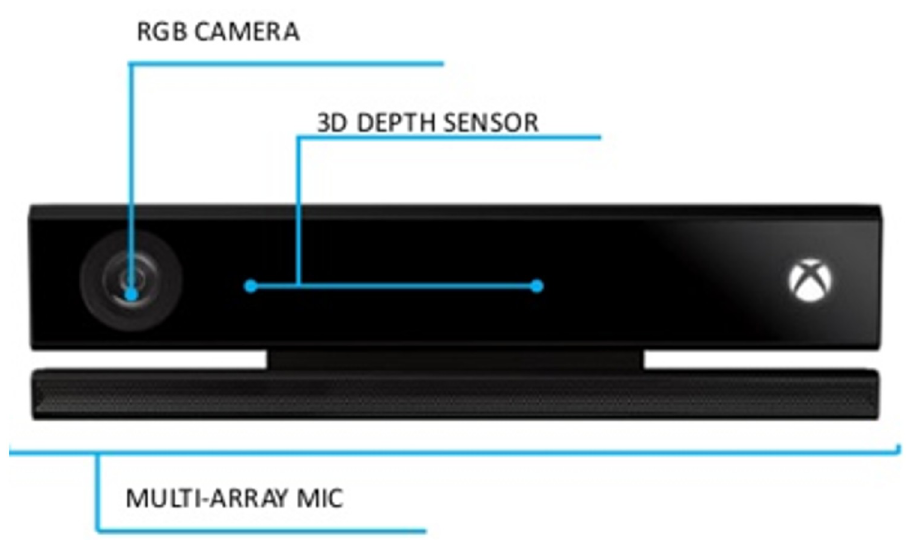
Fig 9. Kinect v2. Depth sensor is in the middle, whereas the microphone array is at the bottom.